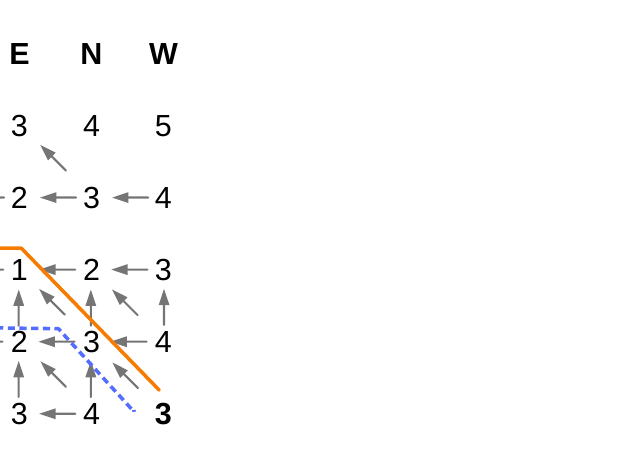
Figure 5. A matrix built with the Needleman–Wunsch algorithm for strings NESW and NEENW. Arrows leaving a cell point to all the optimal alignments of strings that can be trans- formed into the given string by making one of the basic operations. An upward-pointing arrow leaving cell ( i , j ) means that the optimal choice is to copy the i -th symbol from NESW into NEENW—case 1 (cid:13) in Formula (2). An insertion from NEENW into NESW (case 2 (cid:13) ) is indicated by a left-pointing arrow. A diagonal arrow means that matching the i -th character of NESW with the j -th character of NEENW is the best choice (case 3 (cid:13) ). Pursuing the path from the bottom-right cell to the top-left one while performing the appropriate operation at each step allows one to reconstruct the optimally aligned strings. In some cases, two or three choices result in the same cost, which is reflected by two or three arrows leaving the cell. The example at hand has several optimal solutions, two of which have been plotted as colored paths. The solid orange line corresponds to string b being transformed into NE–SW, while the dashed blue line corresponds to this string being transformed into NES–W. All